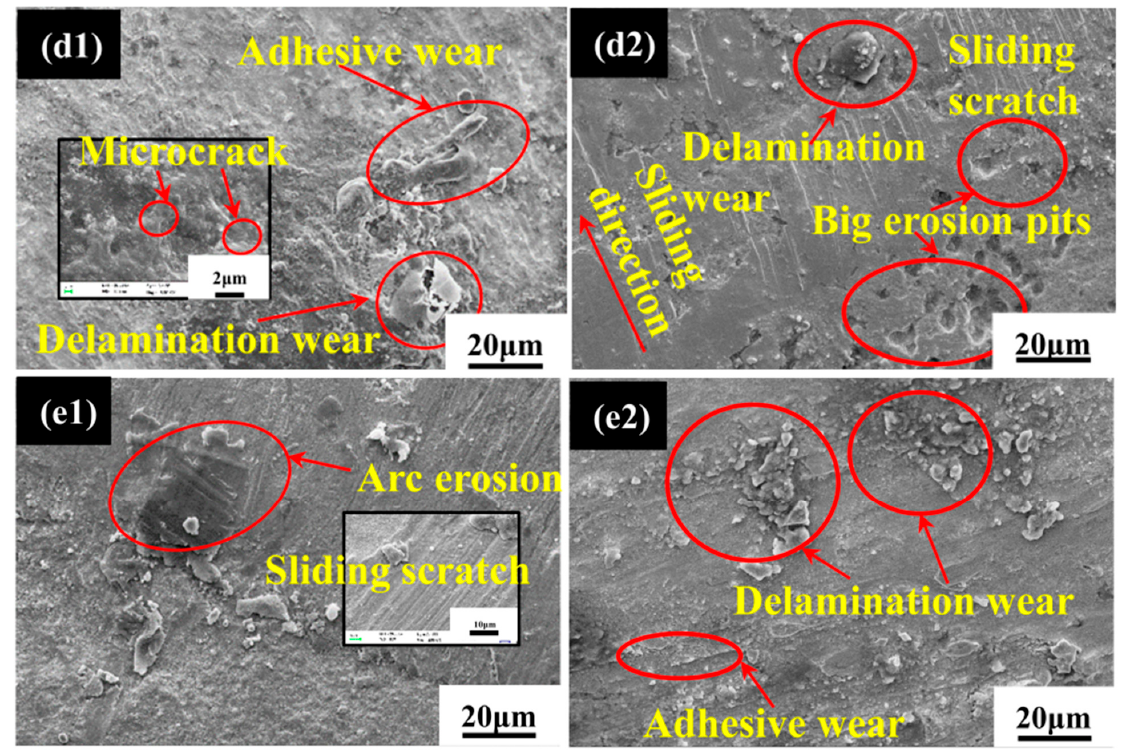
Figure 4. Micro-morphology of the contact surface after 120 min sliding in air ( a1 )–( e1 ) and insulating oil ( a2 )–( e2 ) at the speed of ( a1 ) and ( a2 ) 24 mm/s, ( b1 ) and ( b2 ) 50 mm/s, ( c1 ) and ( c2 ) 76 mm/s, ( d1 ) and ( d2 ) 95 mm/s and ( e1 ) and ( e2 ) 119 mm/s. Table 2. Micro-morphology characteristics at different sliding speeds in air and insulating